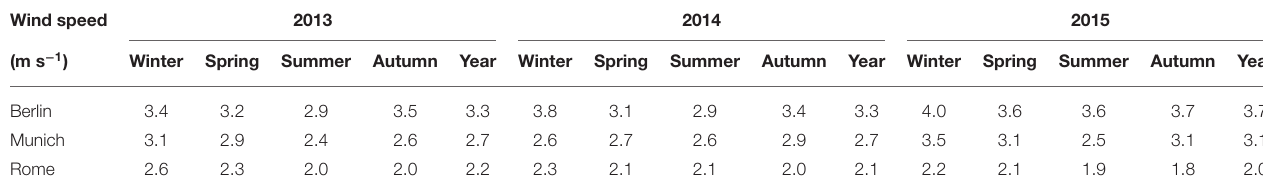
TABLE 5 | Seasonal and yearly average wind speed. Wind